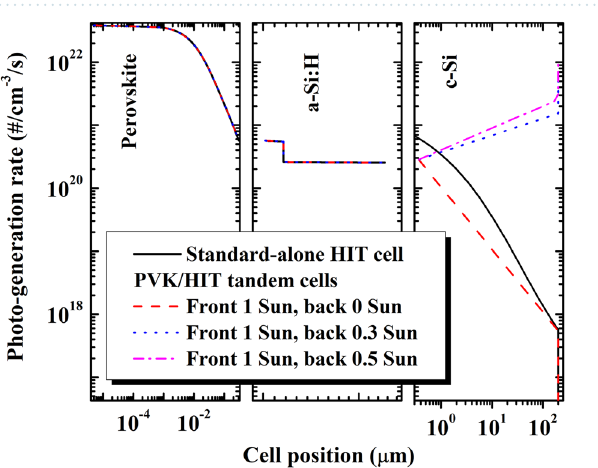
Table 2. Summary of photovoltaic parameters for semitransparent PVK, a-Si:H/c-Si HJ solar cell under 1.0 sun (front) and 0.5 sun (back) and for the summed 4-terminal bifacial PVK/c-Si tandem device.